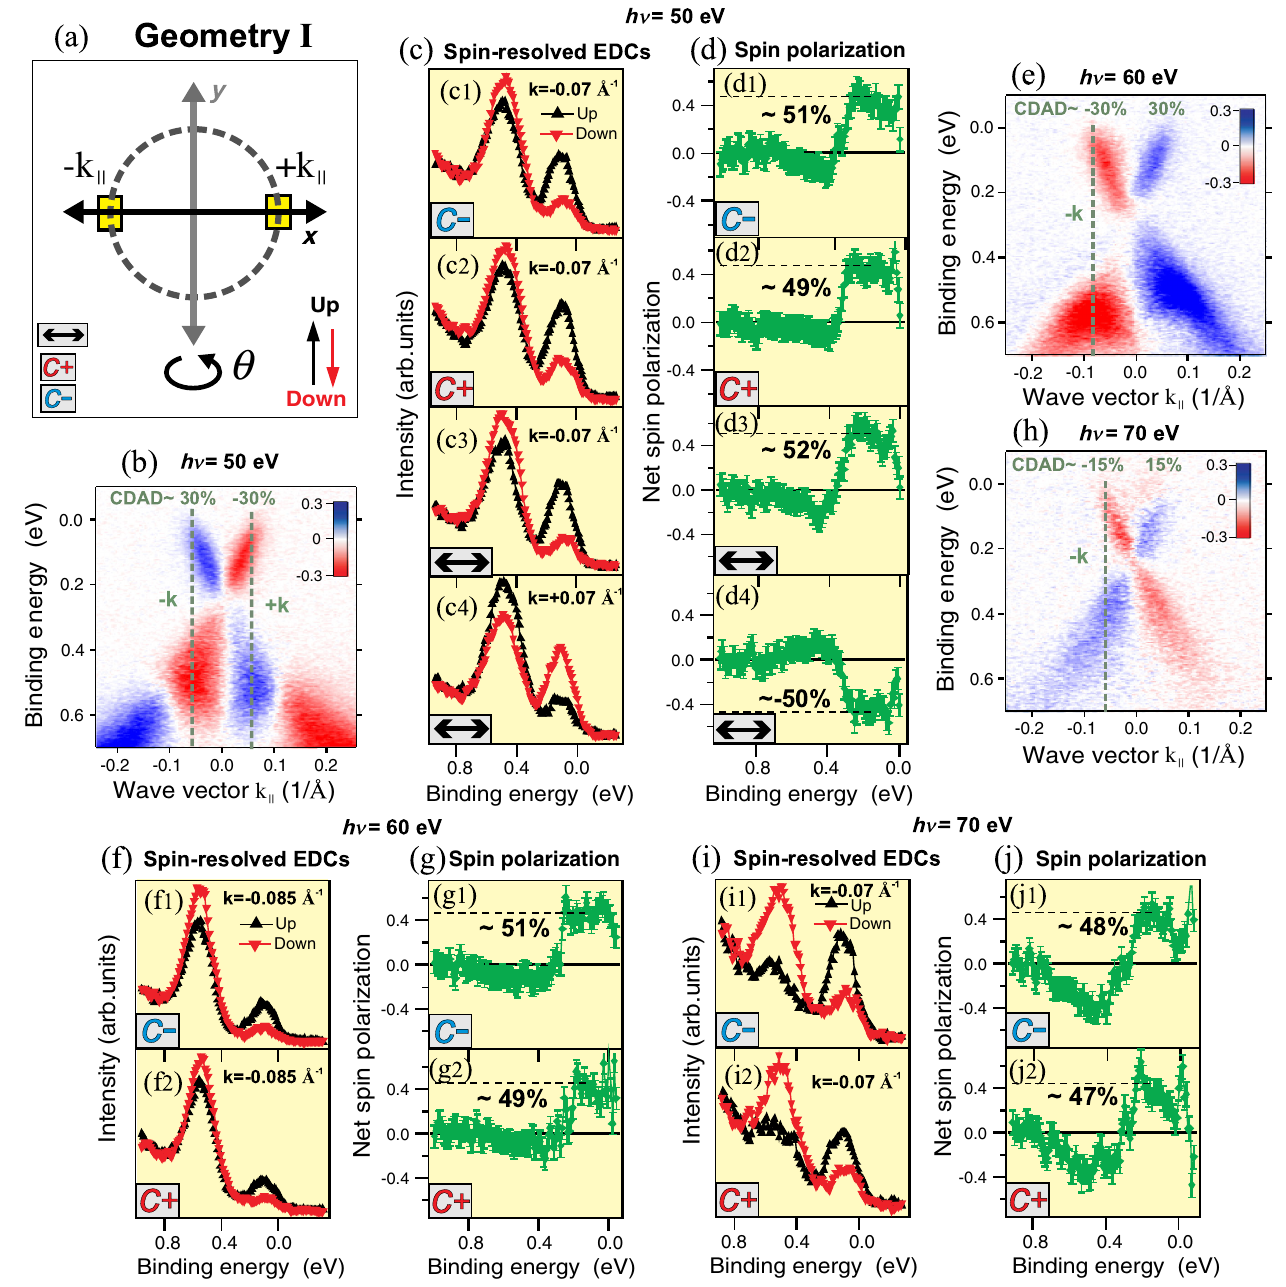
FIG. 1. Observation of the initial-state in-plane spin polarization upon reversal of the CDAD effect from the TSS using (a) geometry I (where the polar angle θ of the sample is rotated), different photon energies and light polarizations [linear ( ↔ ), circular positive ( C þ ), and circular negative ( C − )]. The dotted circle represents an ideal Dirac cone, and the yellow rectangles represent momentum regions where the SR-ARPES measurements have been taken. (b),(e),(h) k -resolved CDAD asymmetry shown for each photon energy. The dashed green lines on top mark the k ∥ wave vectors for which SR-ARPES measurements are presented. The CDAD values from the TSS near the Fermi level are given at the tops. (c),(f), (i) Spin-resolved energy-distribution curves (EDCs) measured for different wave vectors, photon energies, and light polarizations. The black (red) curves show tangential spin-up (down) EDCs. The spin-up (down) direction is denoted by the black (red) arrow in (a). (d),(g),(j) To the right of each spin-resolved EDC, the corresponding net tangential spin polarization is shown and its magnitude